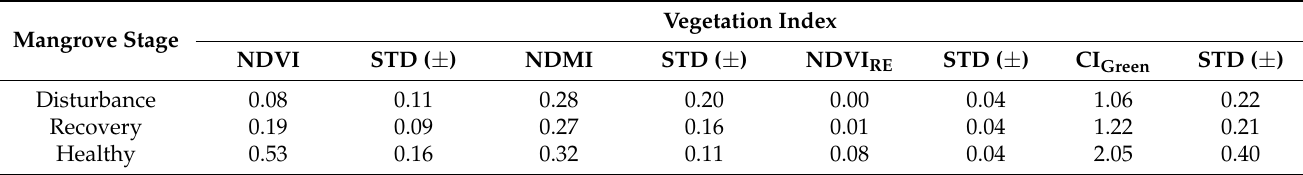
Table 4. The Mean and Standard Deviation of Vegetation Indices for each Mangrove